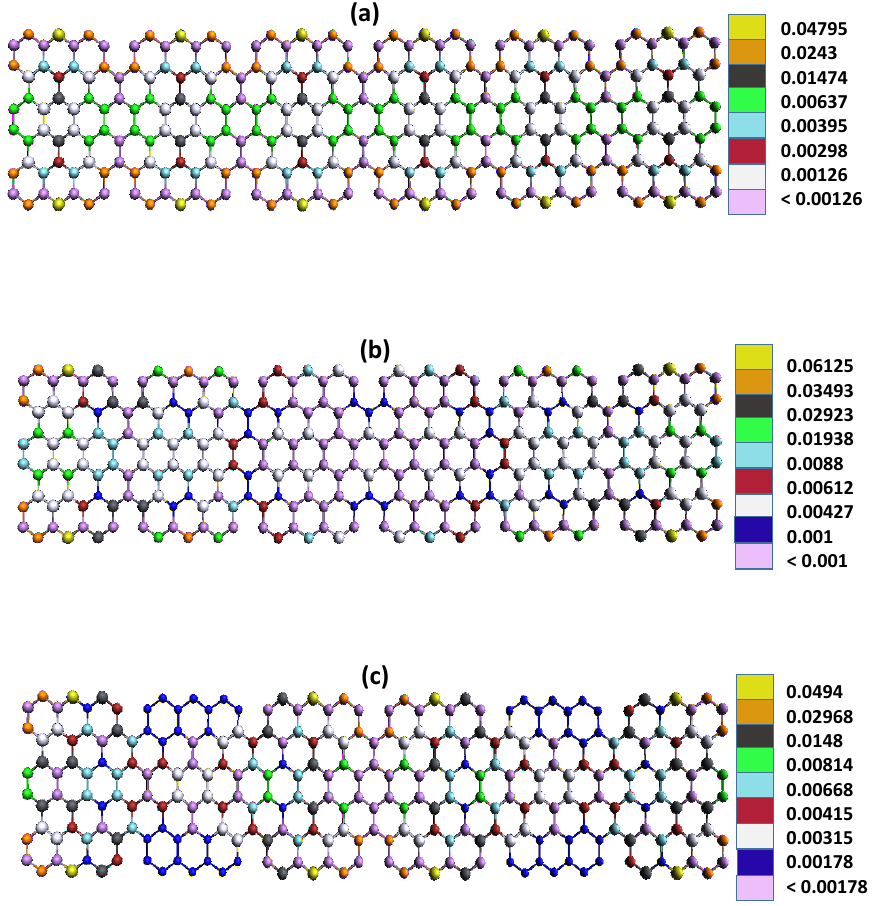
Figure A1. Charge density | Ψ (cid:96) , j ( ε ) | 2 for the t-ZGNR with conductance spectrum shown in Figure 3f. Diagrams ( a – c ) are the charge densities of ε LU = 0.247 eV, ε e ,1 = 0.3105 eV, and ε e ,2 = 0.468 eV,